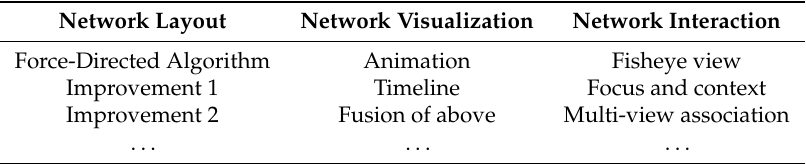
Table 1. A list of the mainstream methods of dynamic